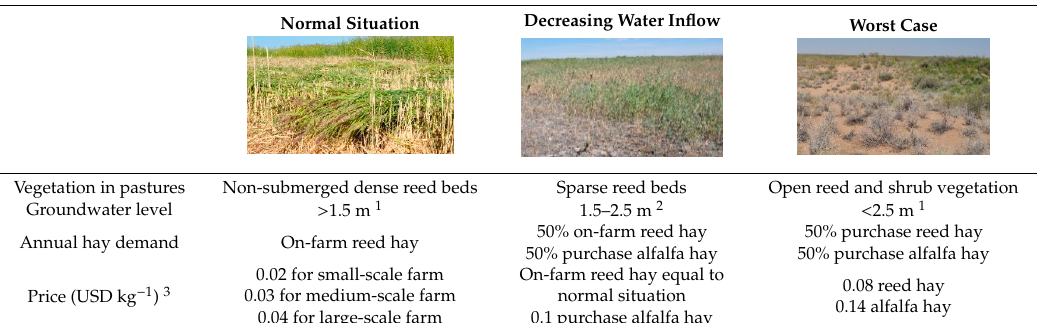
Table 5. Assumptions and calculation parameters for three calculation scenarios (adapted from work in [35]).